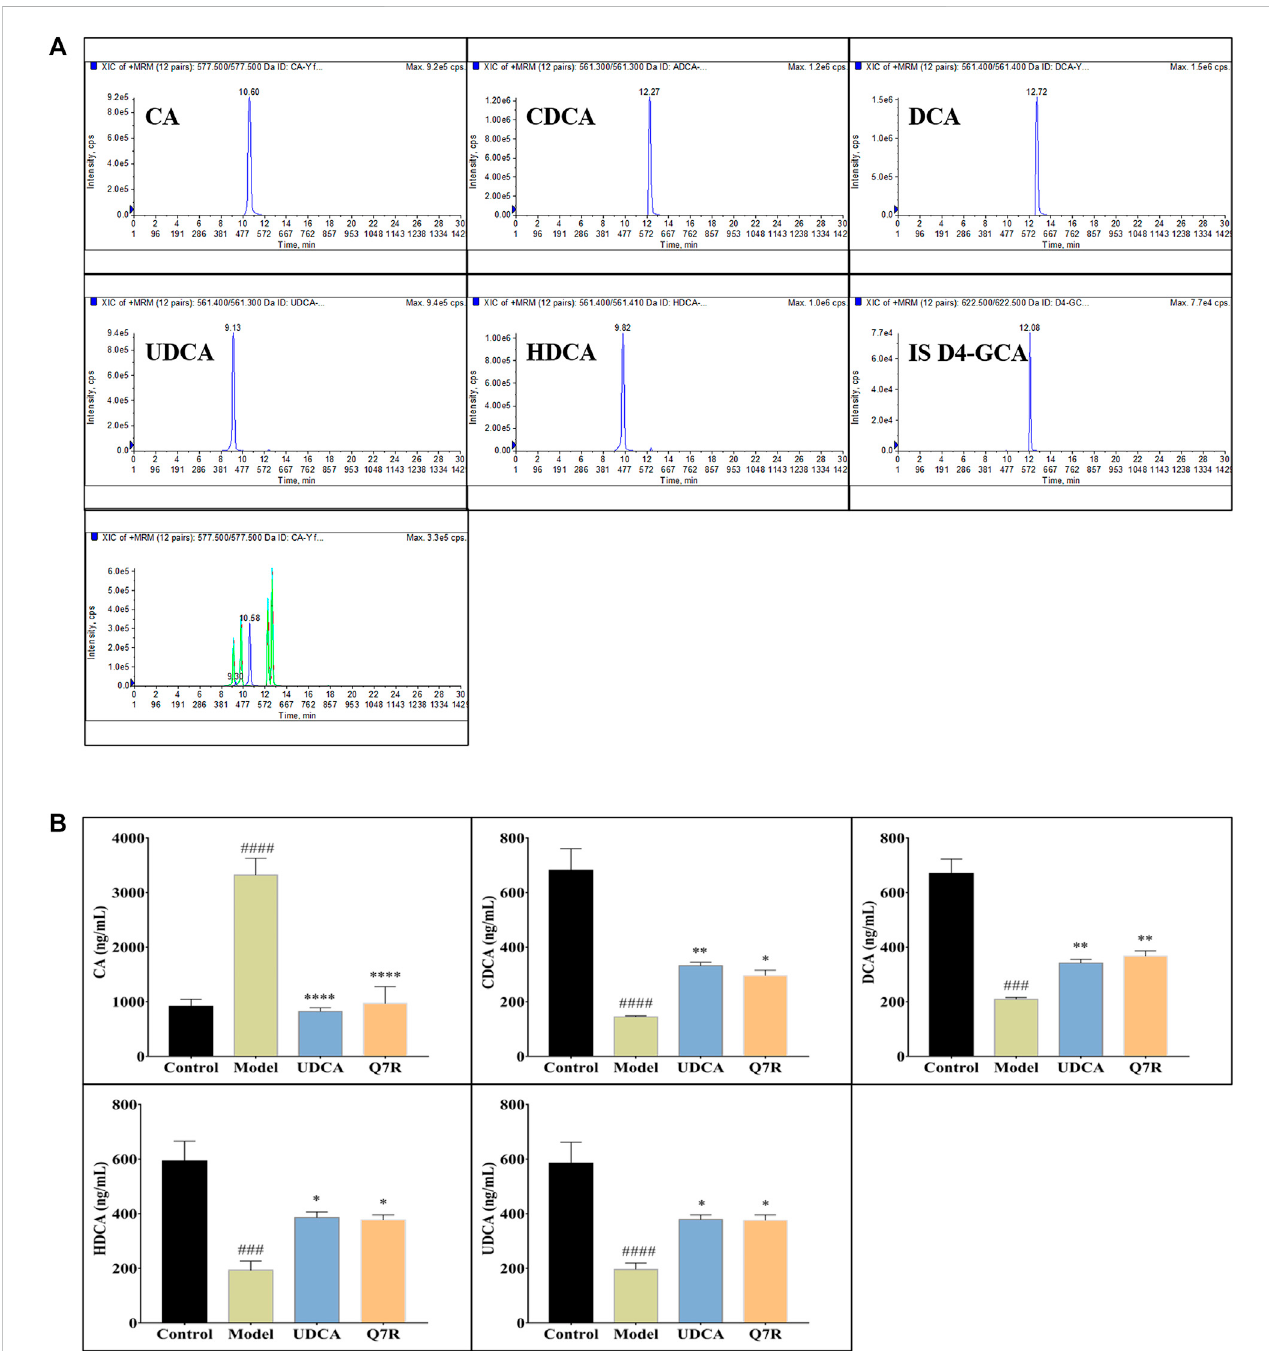
HPLC-MS/MS analysis for serum CA, CDCA, DCA, HDCA and UDCA levels in model rats ( n = 6). (A) Typical chromatograms of CA, CDCA, DCA, HDCA, UDCAandinternalstandard(D4-GCA); (B) SerumCA,CDCA,DCA,HDCAandUDCAlevels.Valuesarepresentedasmean±SEMforthreebiologicalreplicates per group. * p < .05, ** p < .01, **** p < .001 vs. the model group, ### p < .005, #### p < .001 vs. the control